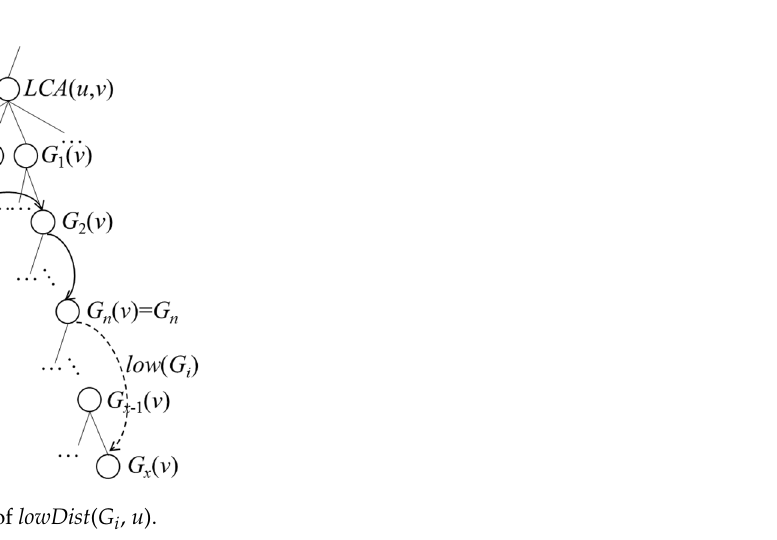
Figure 6. G + -tree nodes passed through from u to v .